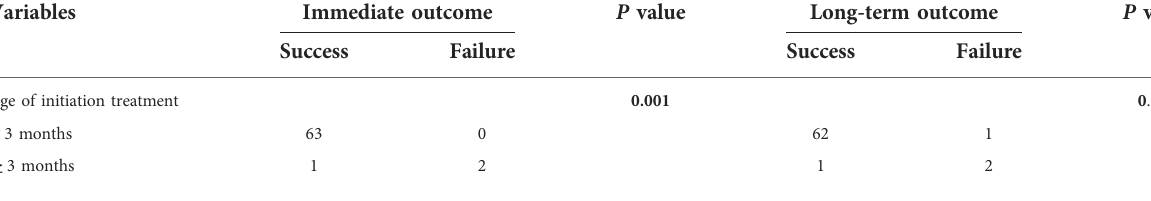
TABLE 3 Age of initiation treatment affecting molding effectiveness for helix adhesion ear.